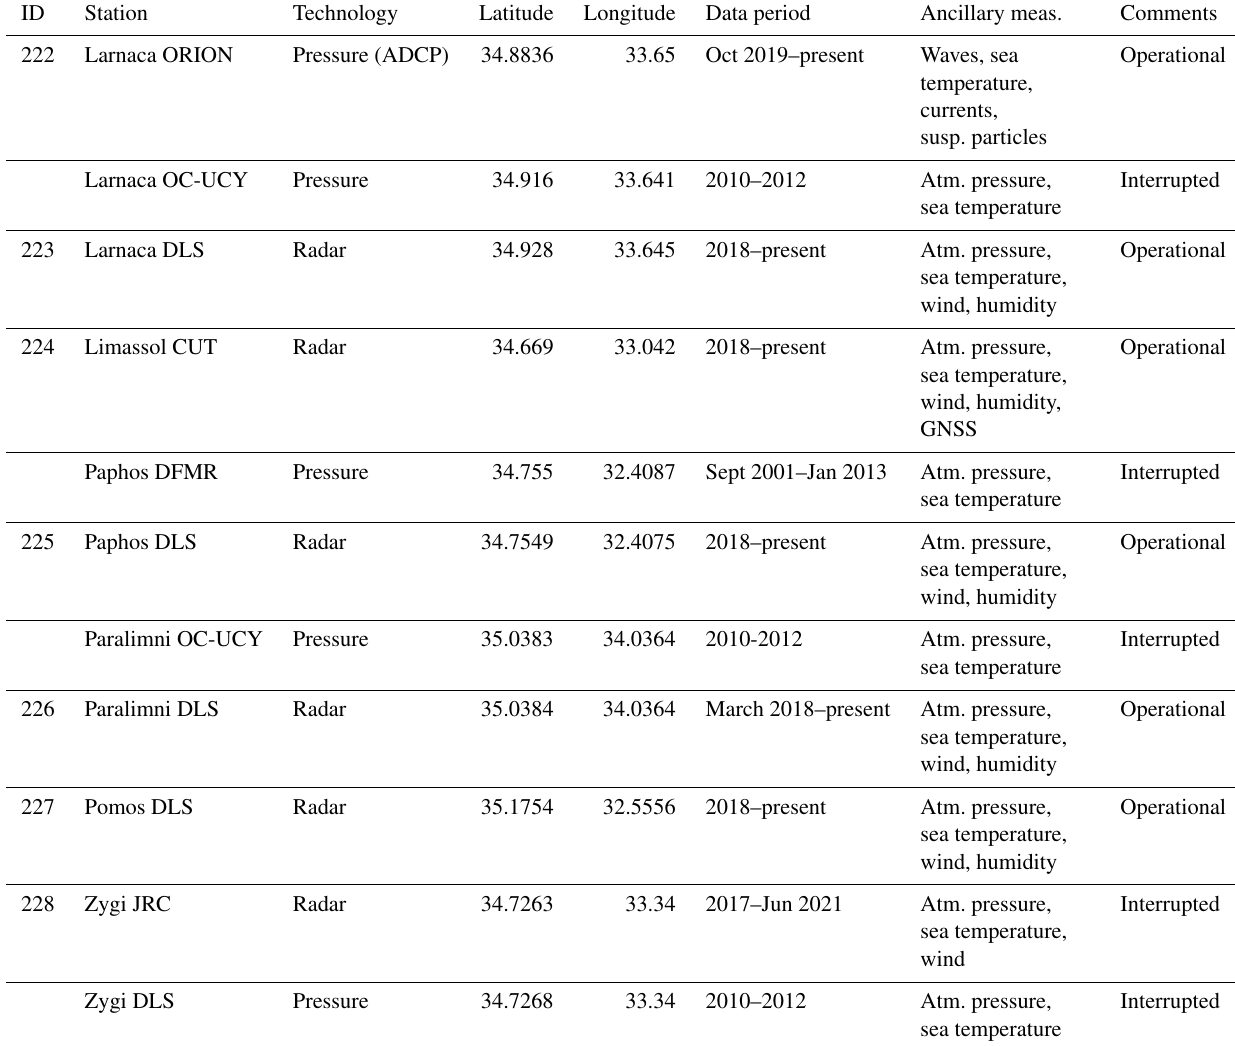
Table A23. Cyprus sea level/tide gauge stations deployed/operated by the DFMR, OC-UCY, DLS, CUT, JRC, and ORION.